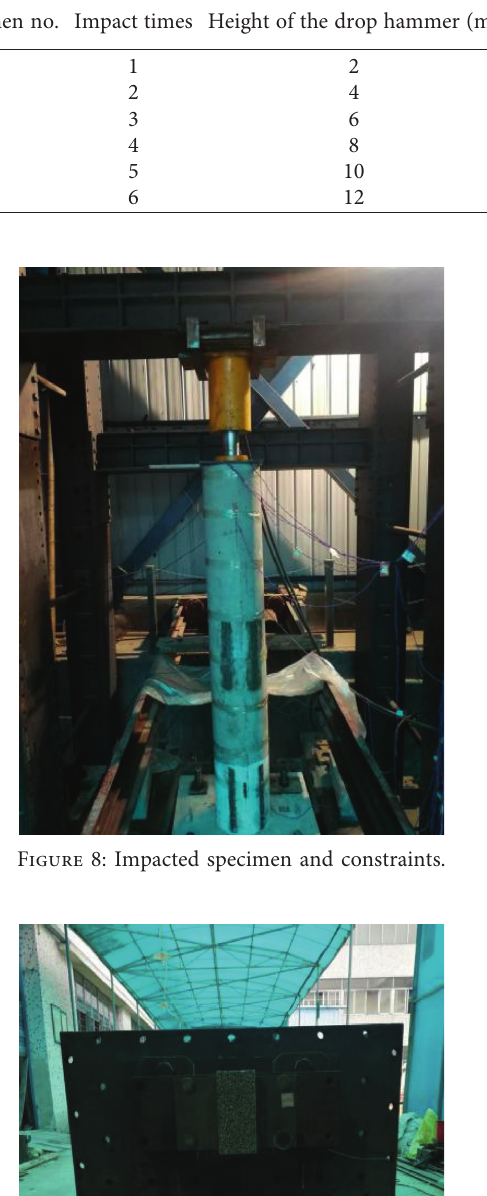
Table 6: Impact scheme.